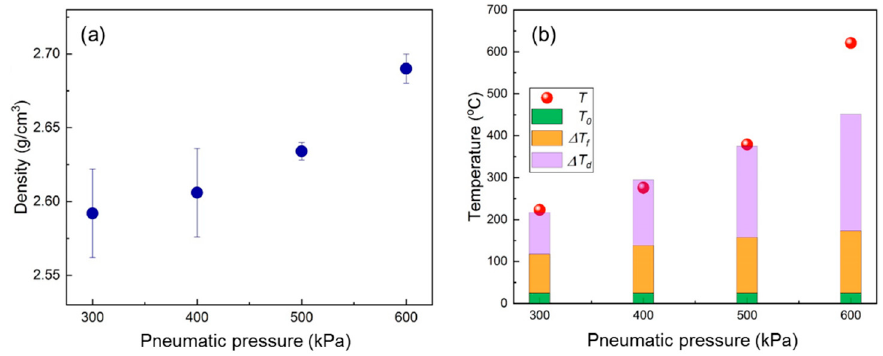
Figure 4. ( a ) Density of the sintered aluminum specimens using UAS method. ( b ) Experimental measured maximum temperature T during ultrasonic sintering. Theoretical calculated temperature rise caused by interparticle friction ∆ T f and plastic deformation ∆ T d are also presented for comparison.